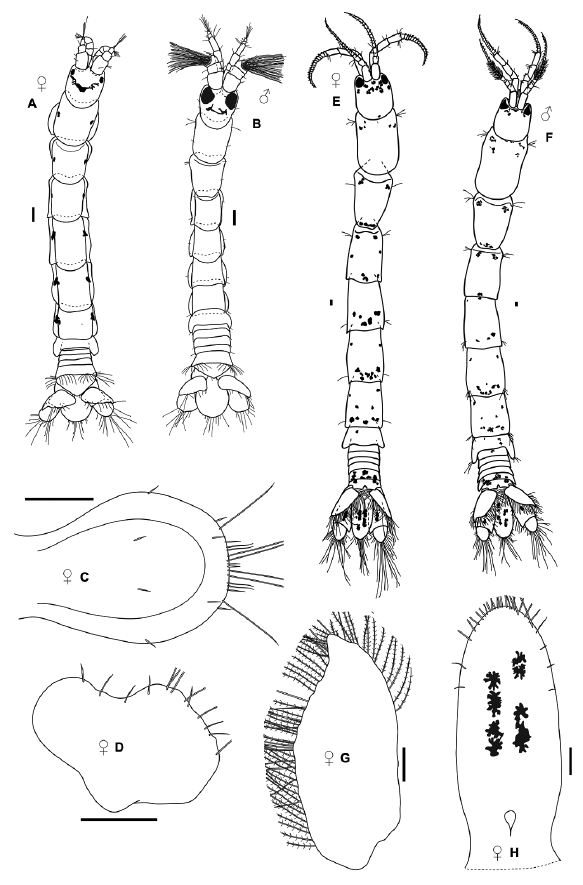
Figure 6. A–D. Expanathura collaris. A. female. B. male. C. pleotelson. D. uropodal exopod. E–H. Accalathura borra- dailei . E. female. F. male. G. uropodal exopod. H. pleotelson. All scales represent 0.1